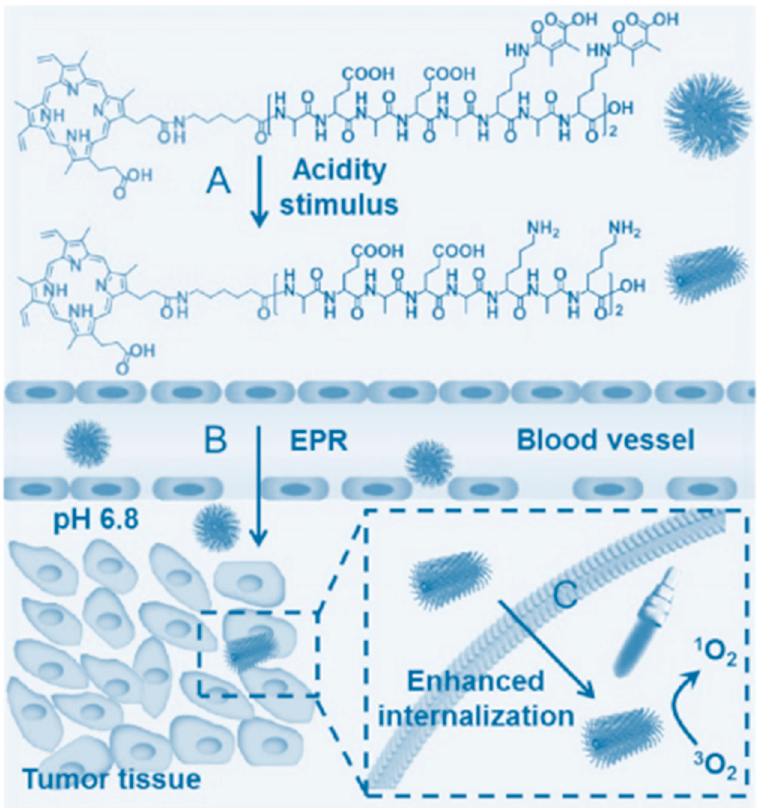
Figure 2. Schematic illustration of acidity-triggered geometrical shape switch and enhanced PDT. Copyright (2017) American Chemical Society [76].